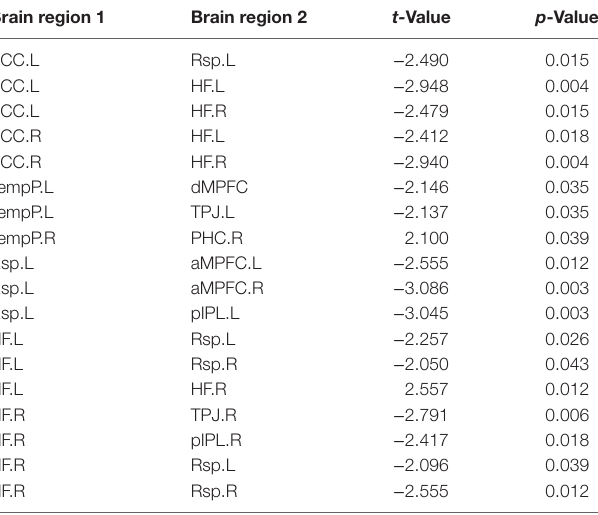
Table 3 | Abnormal functional connectivity (FC) within the default mode network (DMN) between patients with obstructive sleep apnea (OSA) and good sleepers (GSs).